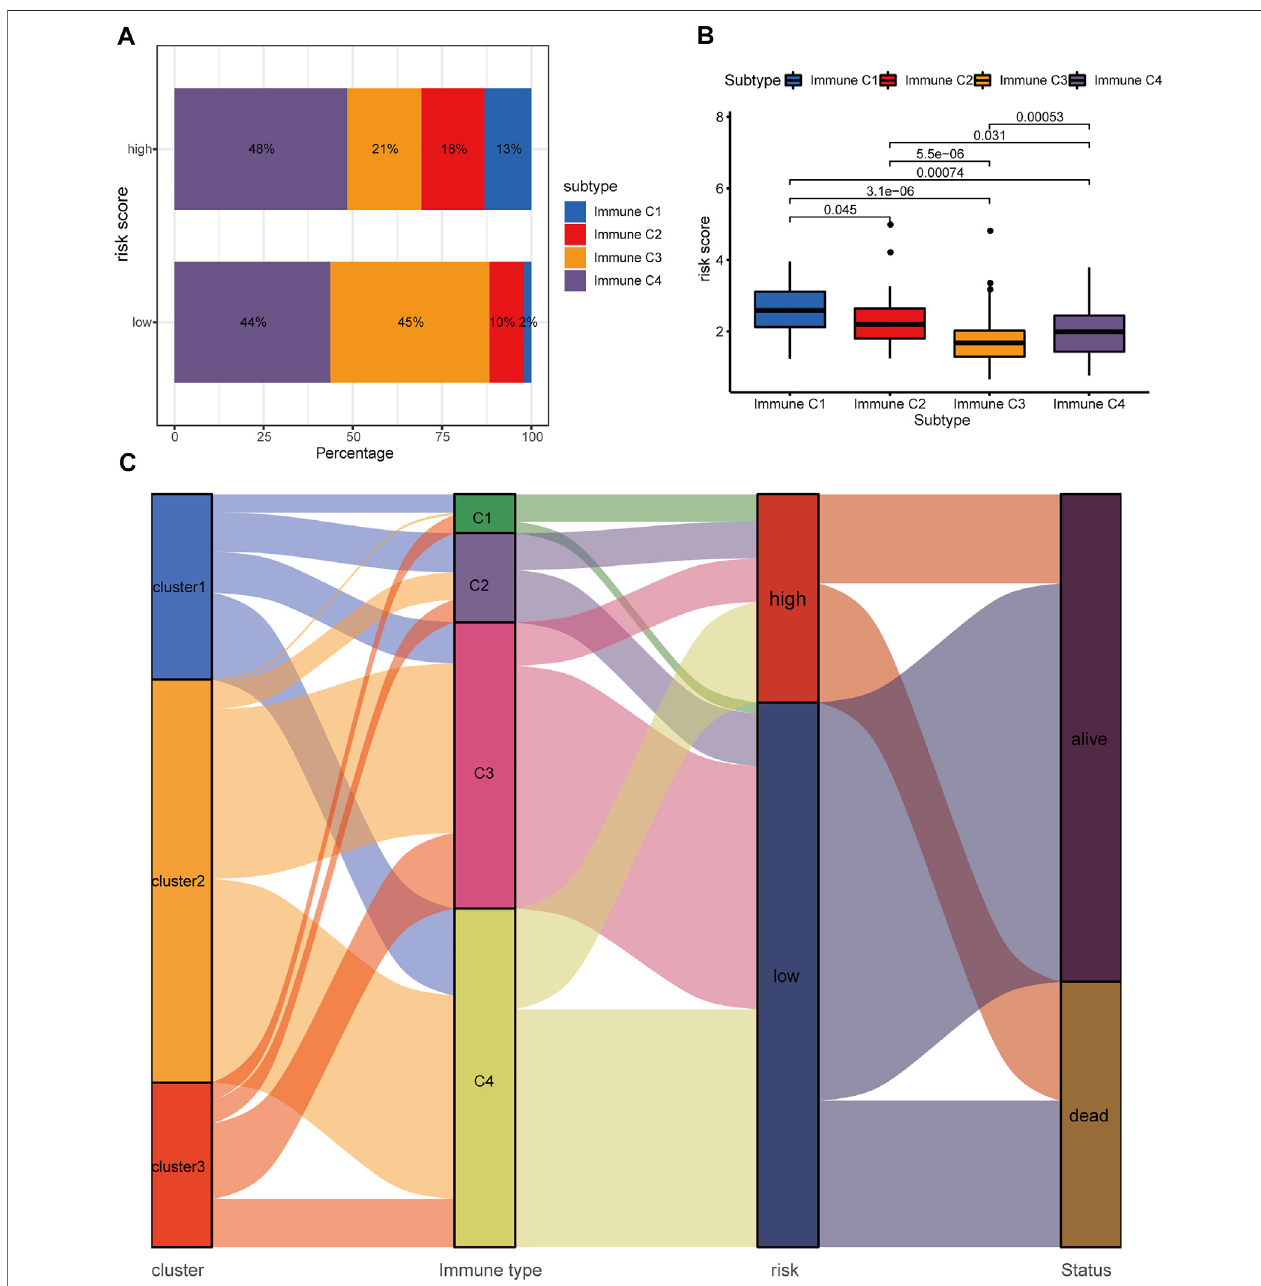
FIGURE 11 | Correlation between the hypoxia-related lncRNA signature and classical immune subtypes. (A) Comparison of the distributive difference of the immunesubtypesbetweenthetworiskgroups. (B) Comparisonsofthehypoxia-relatedriskscoresamongdifferentimmunesubtypes. (C) Thealluvialplotillustratingthe relationship between the HRDELs-speci fi c clusters, classical immune subtypes, hypoxia-related risk groups, and overall survival status. HRDELs: hypoxia-related differentially expressed lncRNAs.